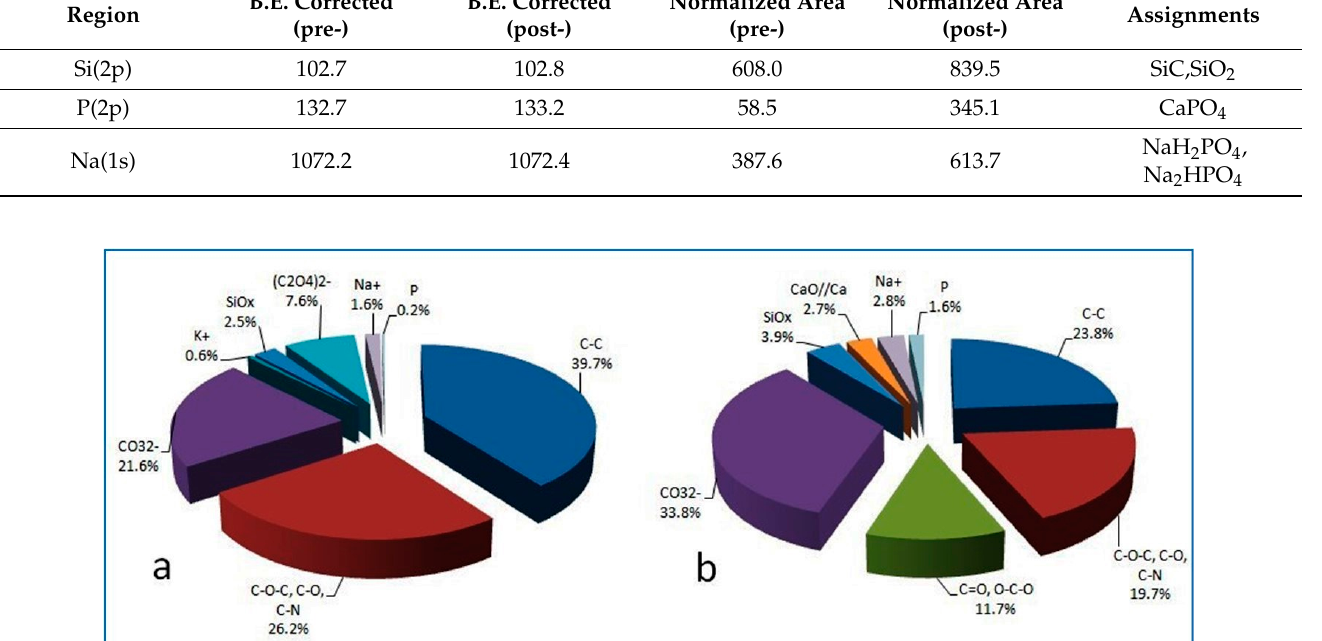
Figure 6. Percentage distribution of the chemical groups determined in the patina samples before ( a ) and after ( b ) treatment with glycoalkaloids.